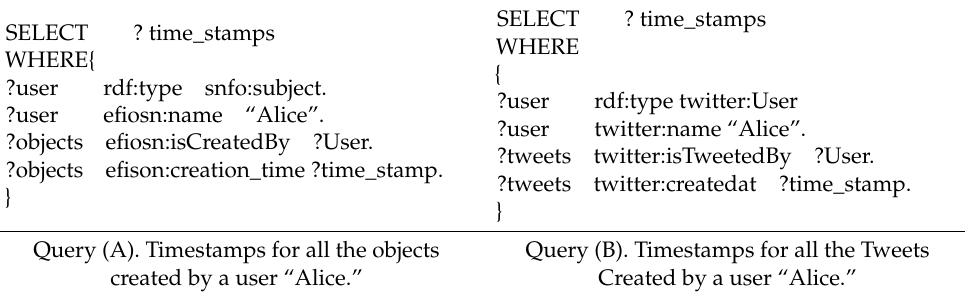
Table 3. SPARQL queries to extract data from RDF